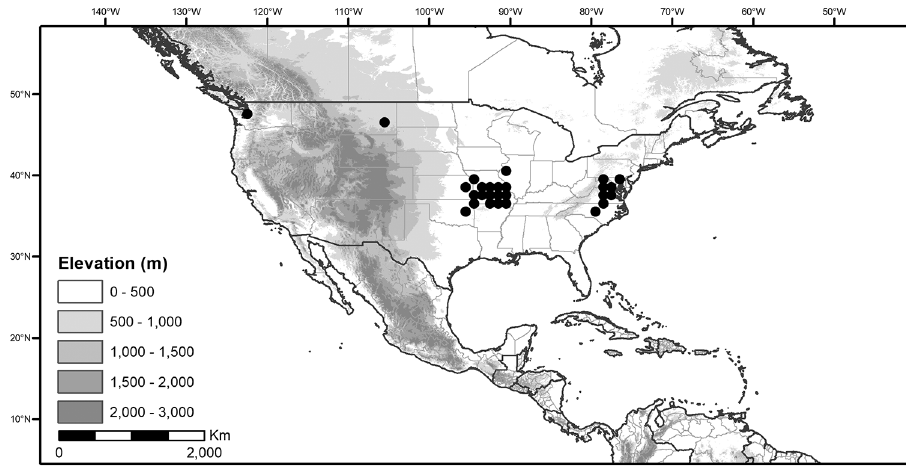
Figure 47. Distribution of Solanum sarrachoides